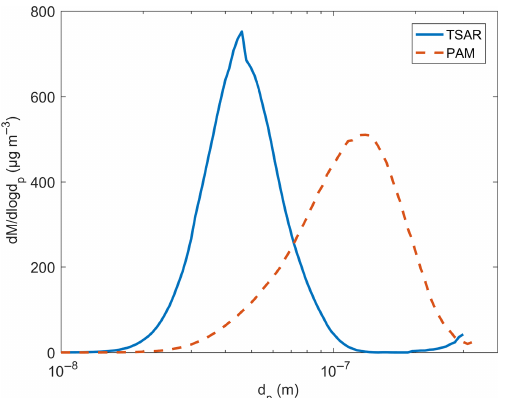
Figure 9. Particle mass size distributions for TSAR- and PAM- generated toluene SOA, obtained from the SMPS particle num- ber size distribution assuming spherical particles with a density of 1.45gcm − 3 .